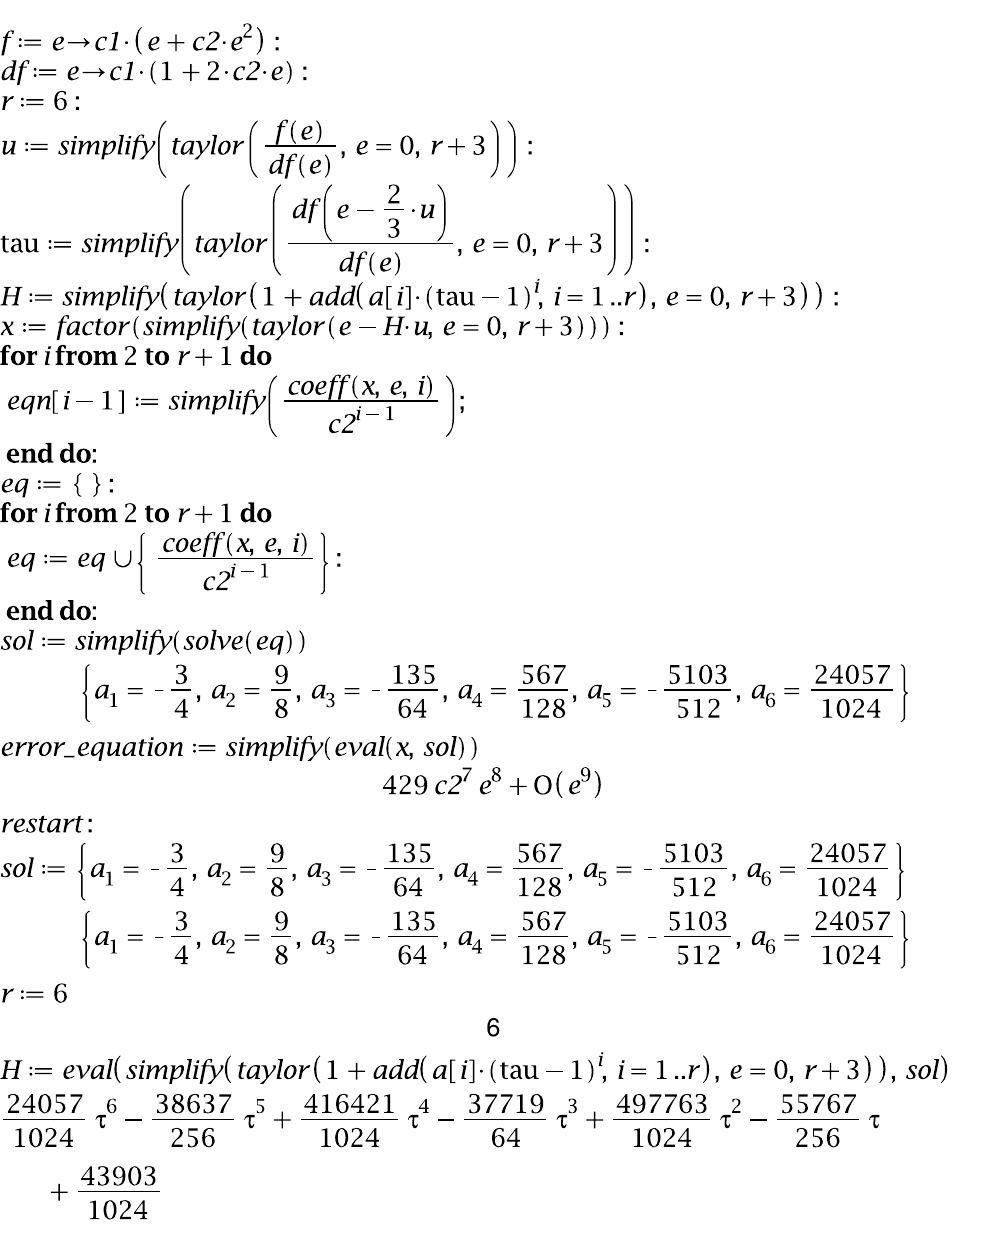
Figure 1. Iterative method Equation